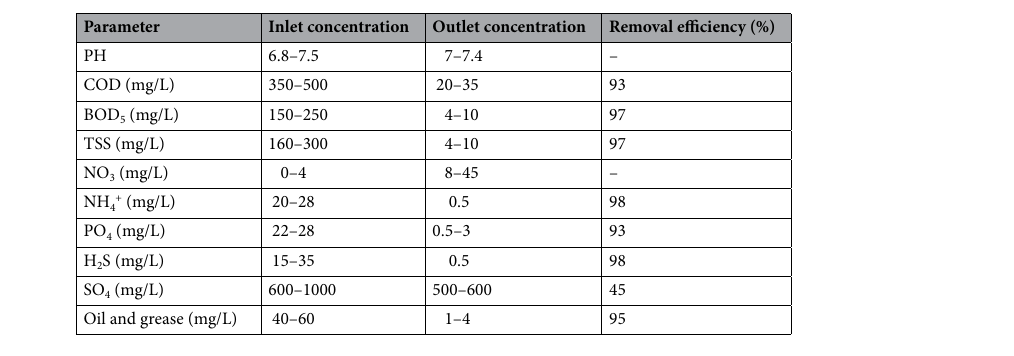
Table 2. Performance characteristics of Karbala WWTP.